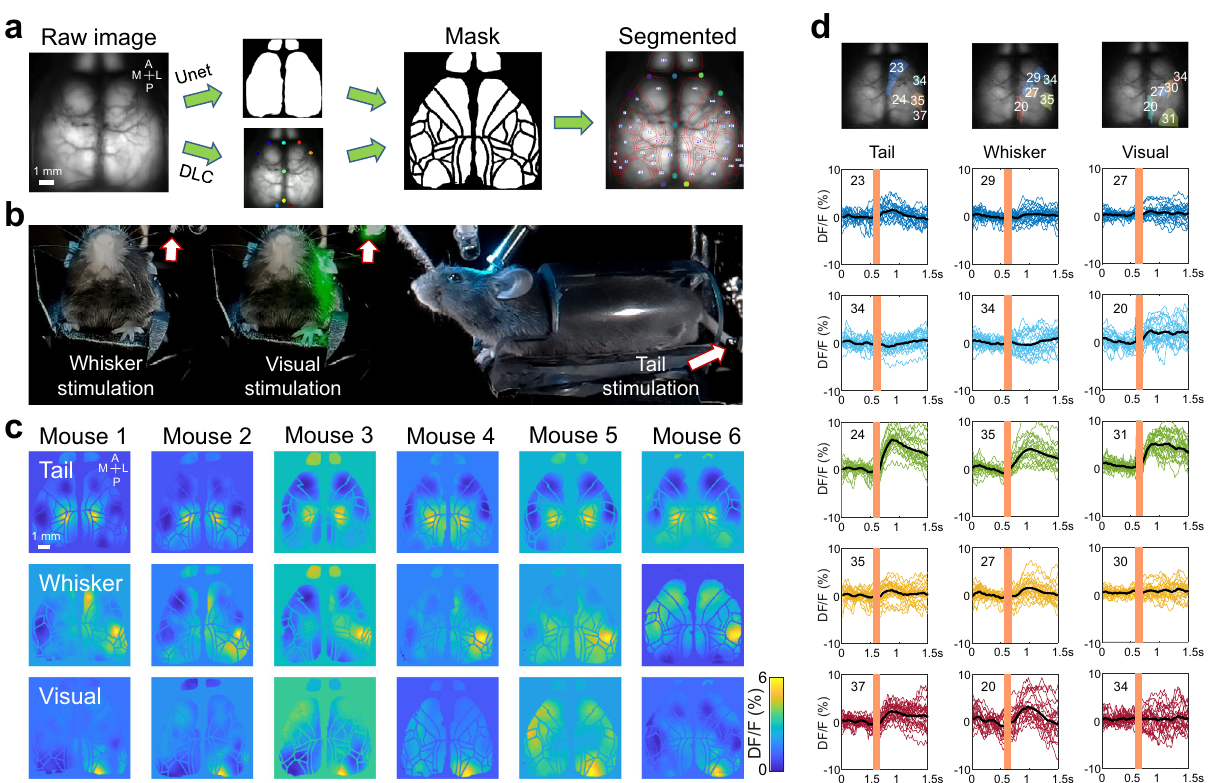
Fig. 4 Sensory mapping in awake mice. a Automated alignment and segmentation pipeline of the atlas-to-brain approach. The raw GCaMP image was segmented using U-Net, and landmark estimation was done using DLC and then combined together to determine each brain region ROI. b Frontal and lateral view of an experimental set-up involving head- fi xed mice with sensory stimulation cranial recording. c Sensory mapping across independent trials ( n = 6 mice) shows similar regions of activation resulting from physical stimulation of the tail or whiskers and visual fi eld of the mouse. d Single trials ( n = 30 trials) of calcium temporal dynamics around the tail, whisker, and visual stimulations of different brain regions (indicated with the same colour on the brain image, the number of brain region ROIs are automatically output from MesoNet). The black line is the averaged calcium response of all the